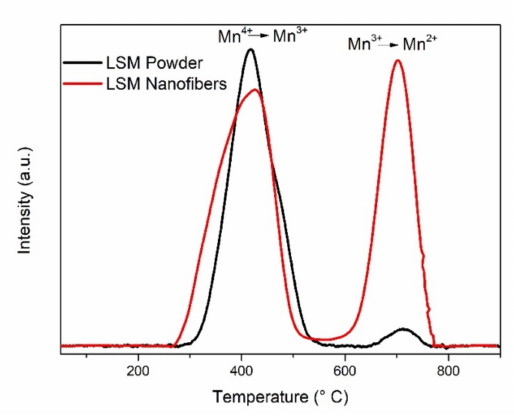
Figure 5. TPR profile of LSM nanofibers and powders. The patterns are normalized with respect to their maximum